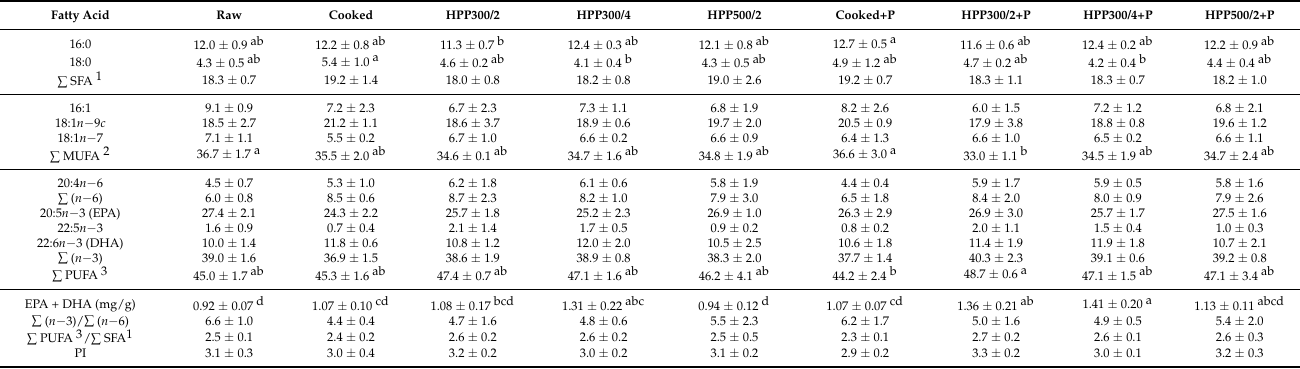
Table 3. Fatty acid composition (percentage of the total detected fatty acids) of meat extracted from raw (i.e., untreated) and processed edible crab